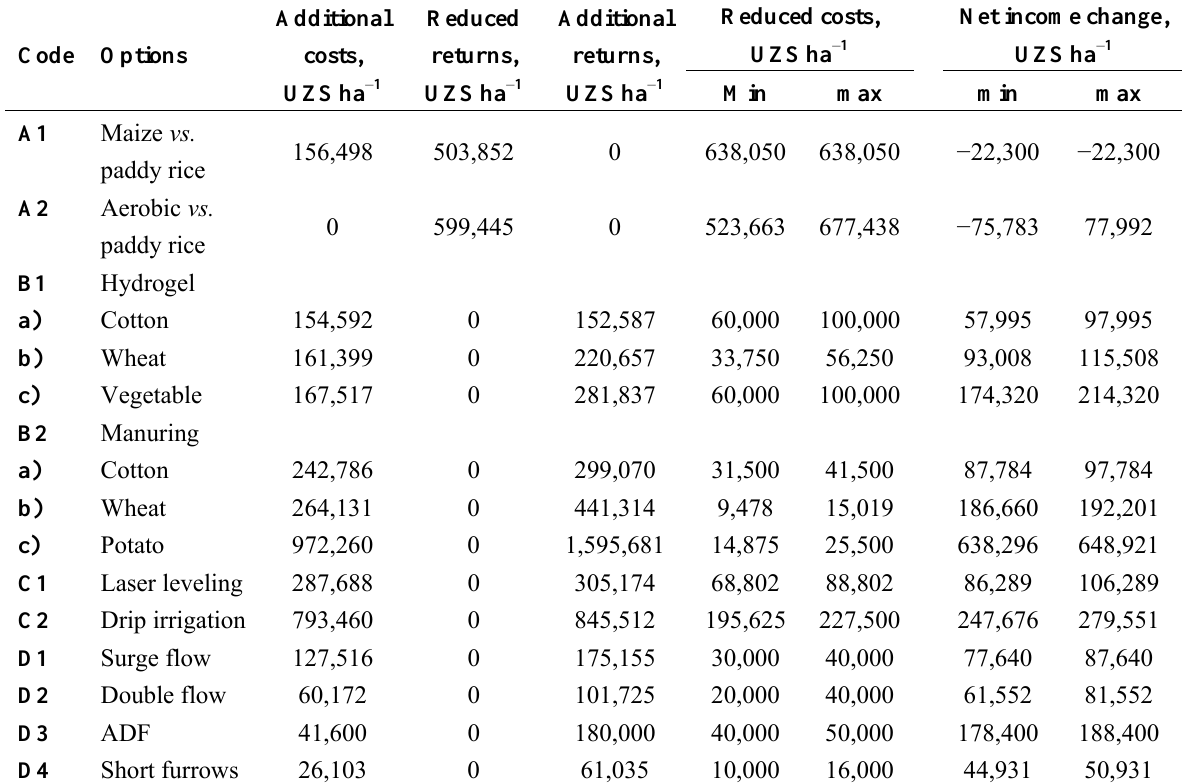
Table 2. Results of partial budget analysis for different water-wise options. UZS = Uzbek Soum (Average exchange rate for 2005: 1,400 UZS = 1